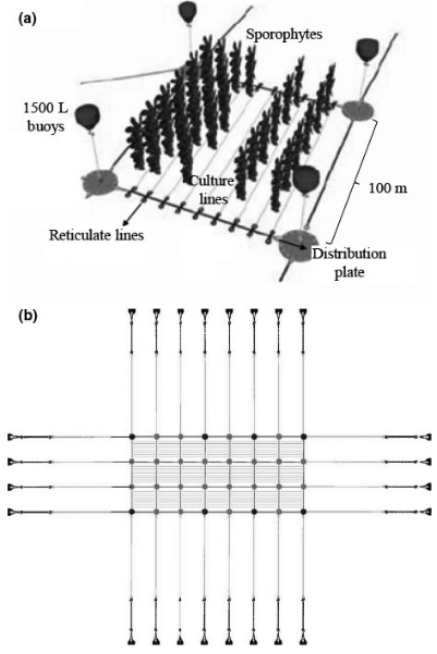
Figure 6. BAL system growing positively buoyant Macrocystis Pyrifera —( a ) 3D partial layout, ( b ) plan-view mooring arrangement [27].